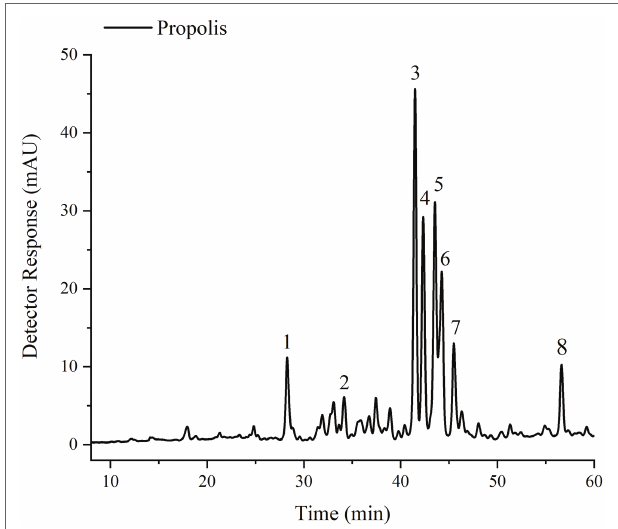
FIGURE 3 | Typical chromatogram of red propolis flavonoids extract obtained from [C 6 mim]Cl. Chromatograms were processed at 280